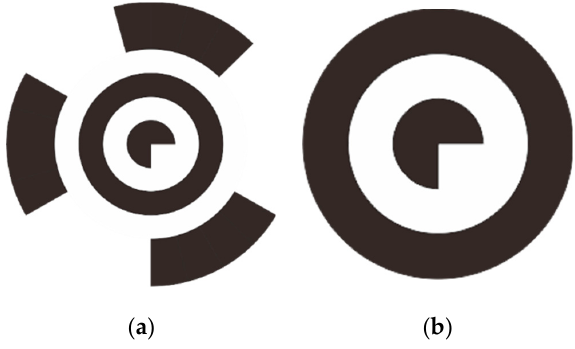
Figure 2. ( a ) The coding graphic example. ( b ) The template graphic.